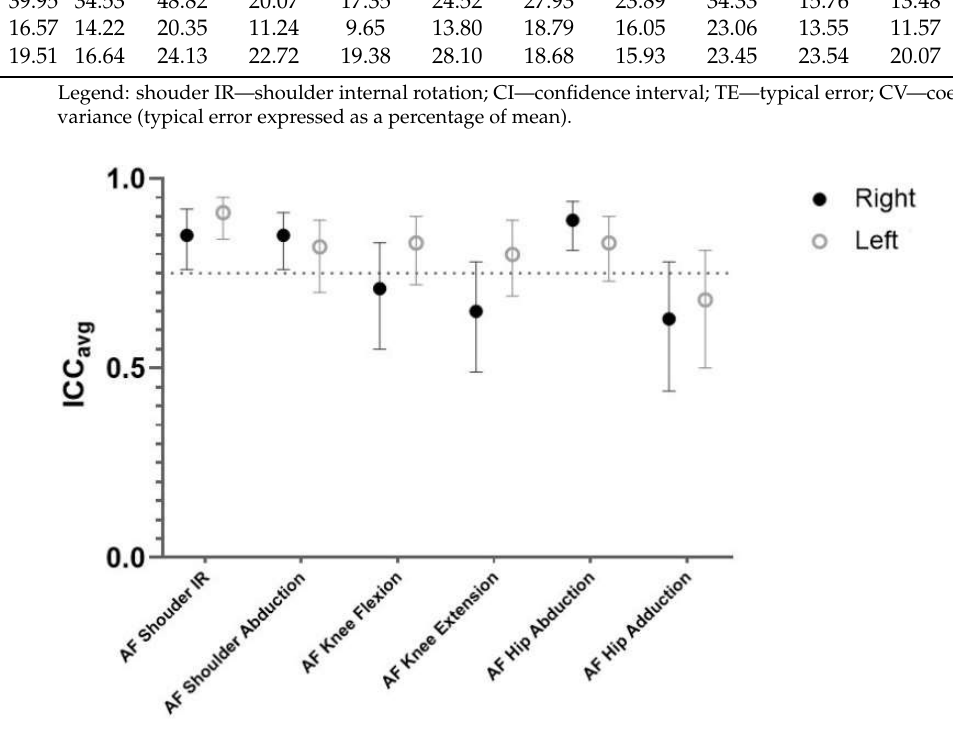
Table 3. Absolute intrarater reliability for shoulder, knee, and hip isometric strength. Right Left